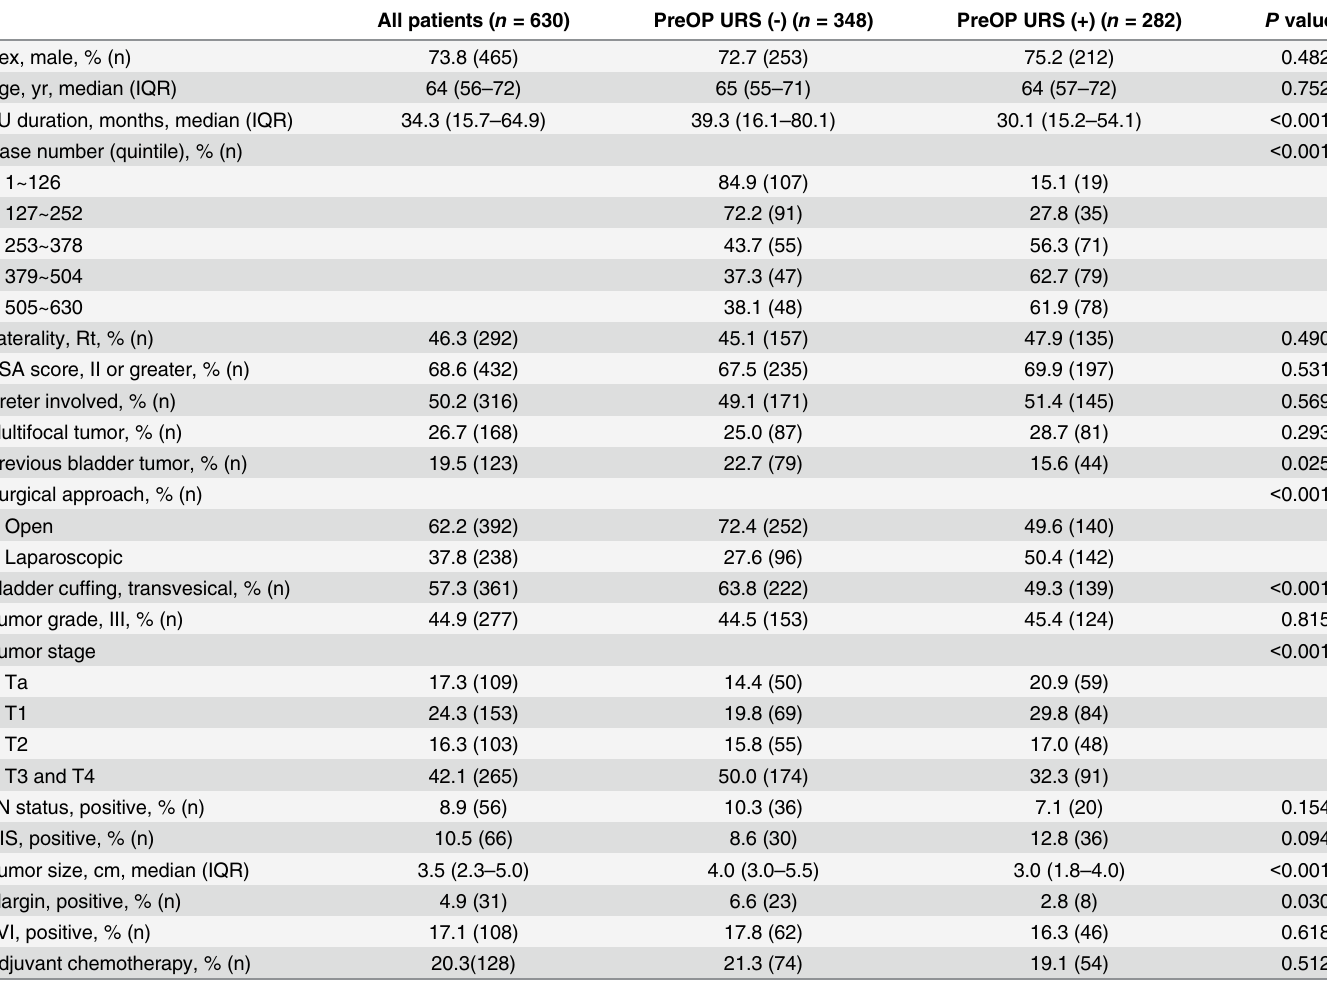
Table 1. Baseline characteristics of all patients, and clinicopathologic features according to preoperative